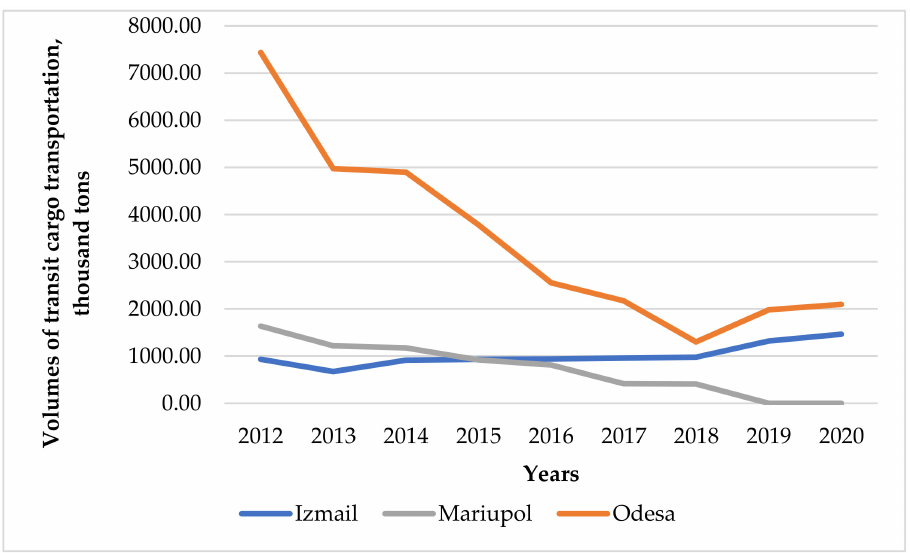
Figure 4. Changes over time in the volume of transit transportation of goods through the ports of Izmail, Mariupol and Odesa, thousands of